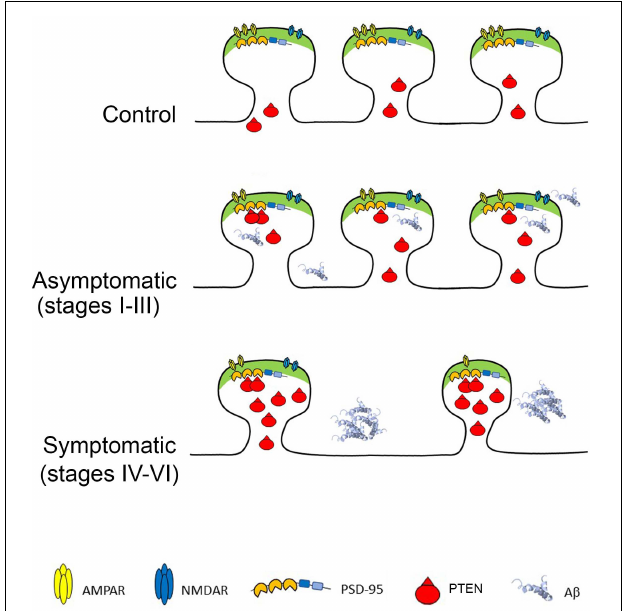
FIGURE 5 | Phosphatase and Tensin Homolog Deleted on Chromosome Ten (PTEN) at AD Synapses provokes Long-Term Depression and synaptic loss. Top: Healthy synapses exhibit basal synaptic transmission due to weak PTEN activity. Middle: in response to A β , PTEN is recruited to the postsynaptic membrane via PDZ-dependent interactions with PSD-95. The turnover of PIP 3 by PTEN facilitates AMPAR endocytosis and removal from synapses. Bottom: When A β is elevated, the sustained recruitment of PTEN at the postsynaptic membrane leads to excessive removal of AMPARs, skewing synaptic plasticity toward depression and producing chronic synaptic weakening, shrinkage and loss. The cell death provoked by A β overload also contributes to synaptic